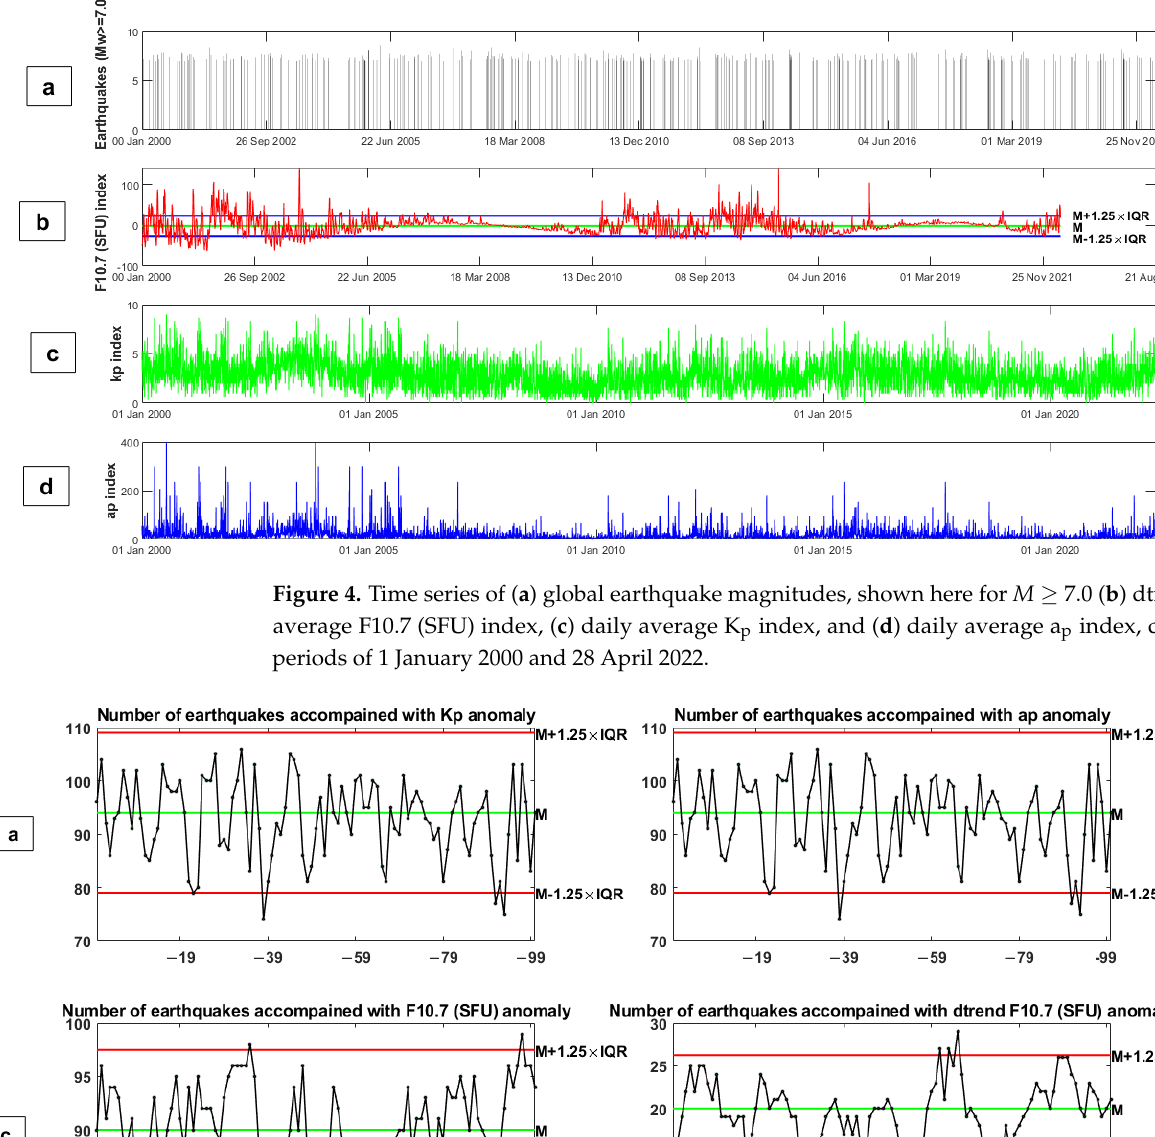
Figure 4. Time series of ( a ) global earthquake magnitudes, shown here for M ≥ 7.0 ( b ) dtrend daily average F10.7 (SFU) index, ( c ) daily average Kp index, and ( d ) daily average ap index, during the periods of 1 January 2000 and 28 April 2022.